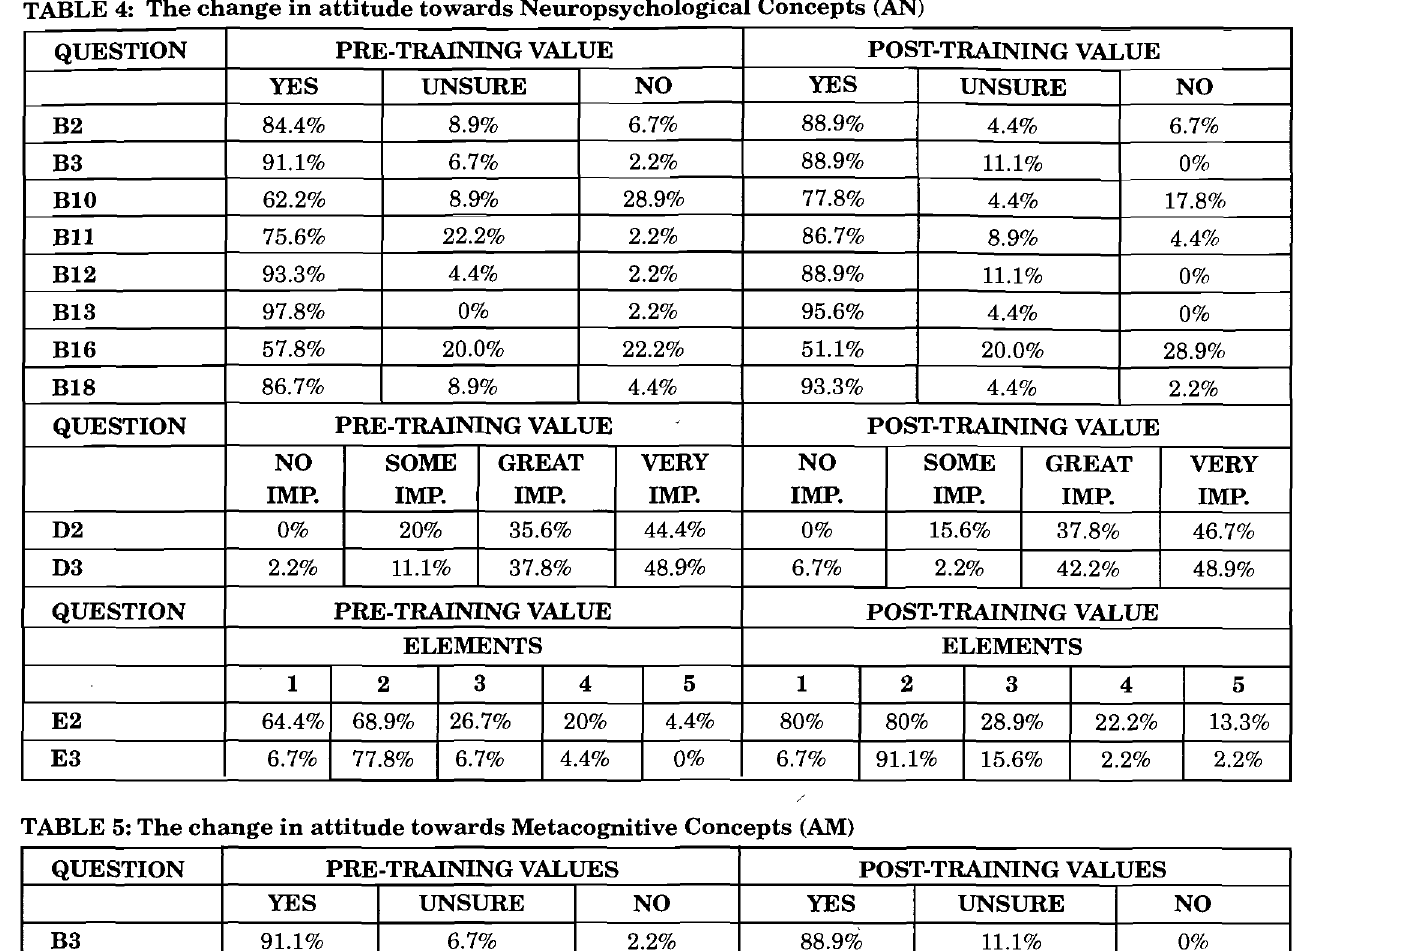
TABLE 5: The change in attitude towards Metacognitive Concepts